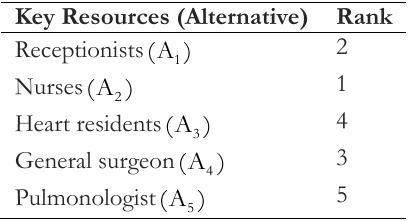
Table 5. Ranking of key